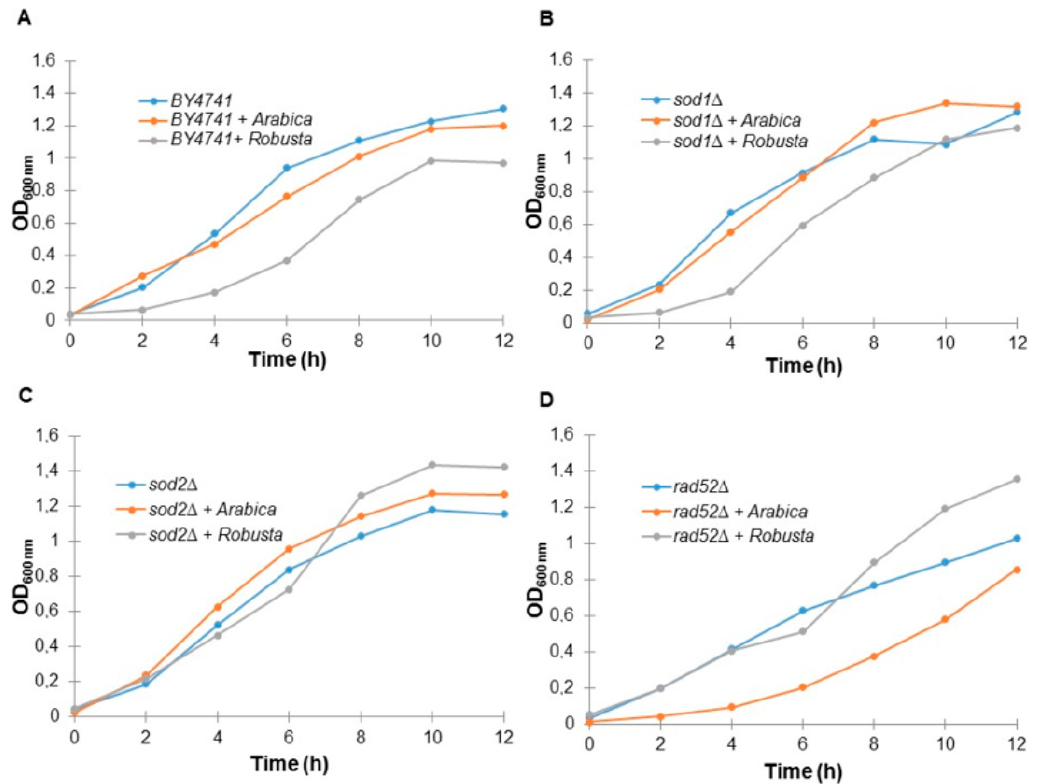
Figure 2. Comparison of growth kinetics of the haploid wild-type yeast strain BY4741 ( A ) and isogenic mutant strains sod1 Δ ( B ), sod2 Δ ( C ) and rad52 Δ ( D ) treated with coffee infusion. The optical density (OD 600 ) of the cultures was measured at different time points for up to 12 h. The presented data are replicates from two independent cultures ± SD where these are smaller or the same size as the symbol dimensions. The data for each condition are representative of at least two independent experiments performed on different days.